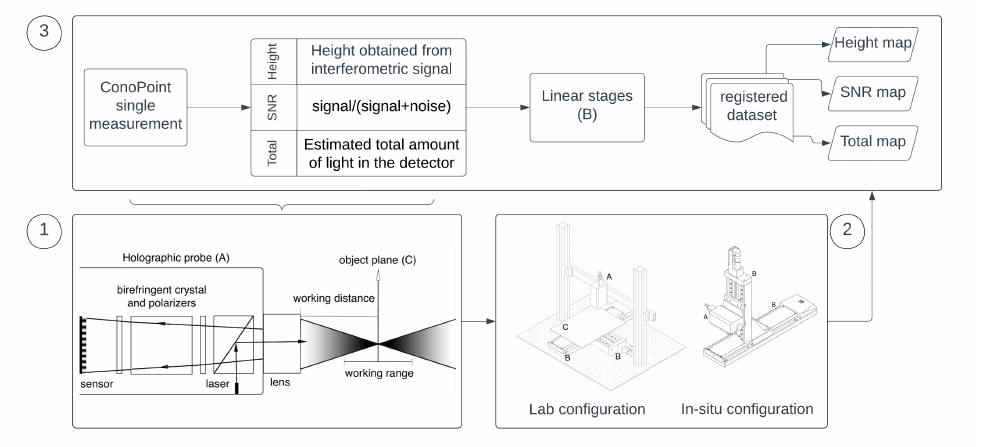
Figure 1. Scheme of the working principle of the microprofilometer. Block 1: Conoscopic holog- raphy probe concept and setup. Block 2: Scanning system setups. Block 3: Datasets: single point measurement acquired by the probe and maps acquired through the scanning